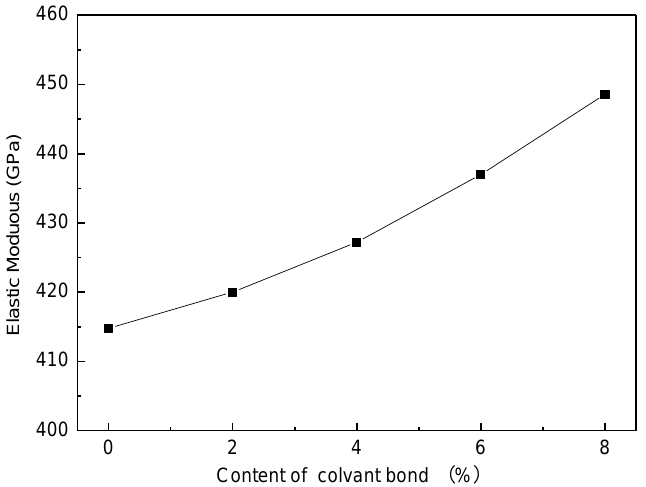
Figure 9. Elastic modulus of CNCs-graphene layered structure with different covalent bond content.